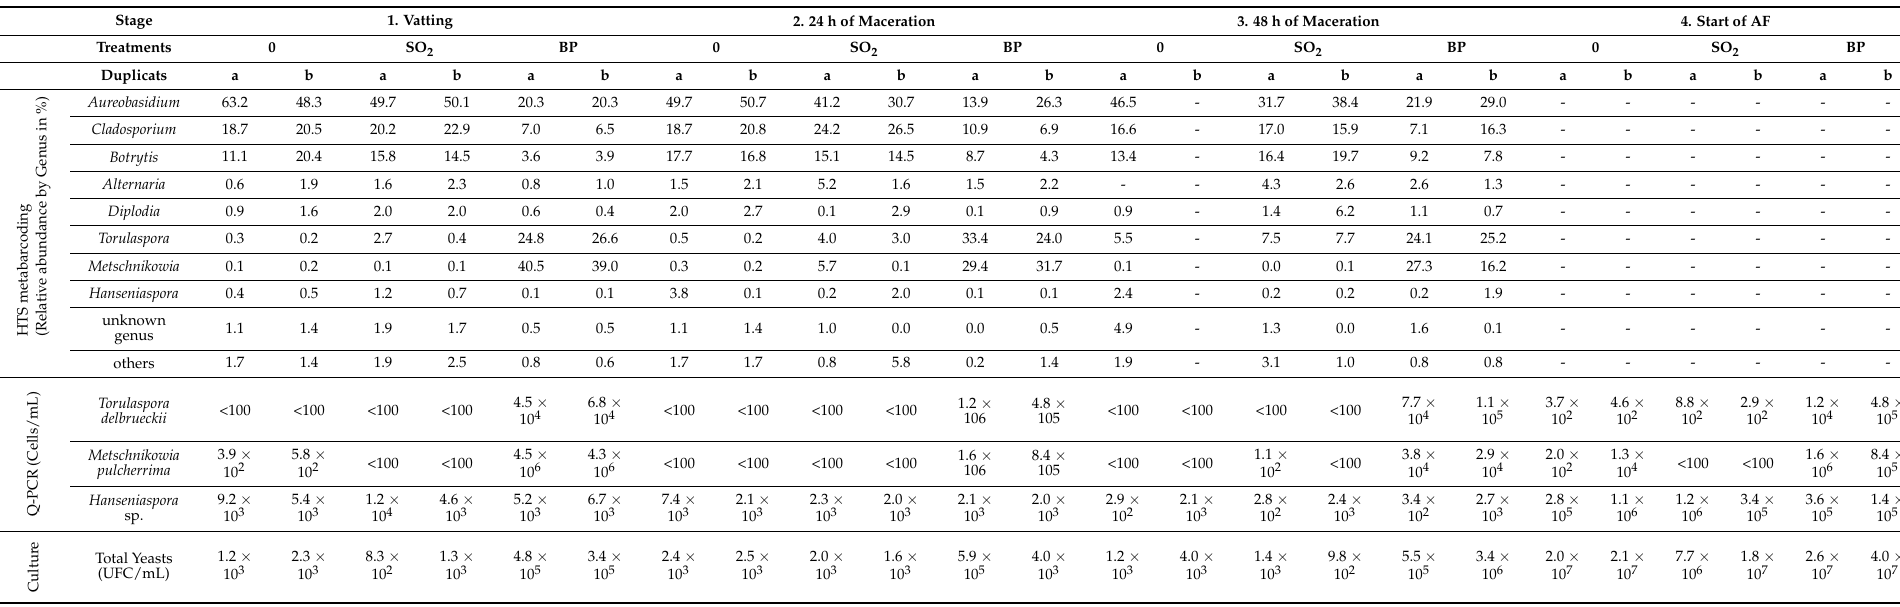
Table A4. The yeast and fungi diversity of three treatments (SO 2 , 0 and BP) at three stages evaluated by HTS, Q-PCR and MALDI-TOF